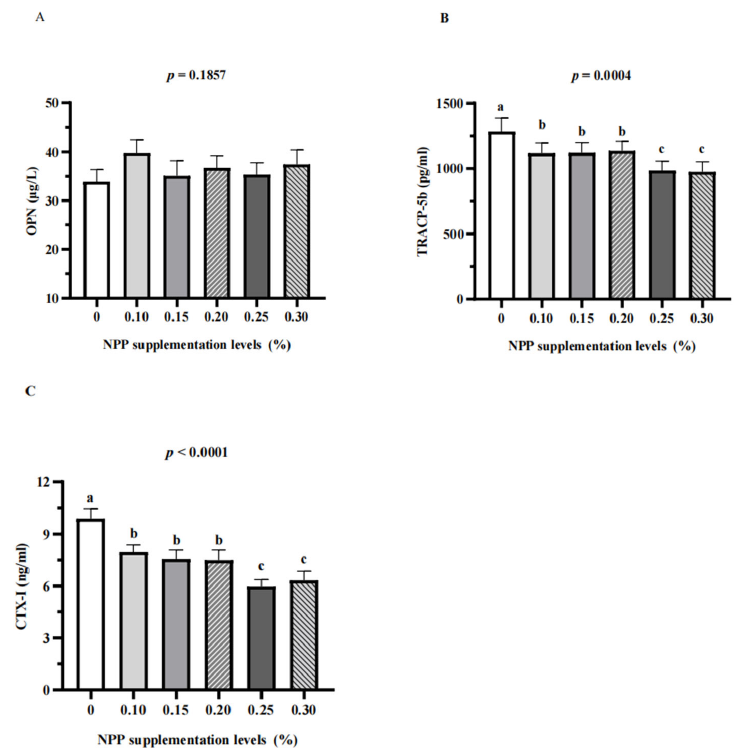
Figure 4. Effect of the level of dietary NPP supplementation on the serum bone resorption markers of Hy-Line Brown laying hens (69–78 weeks of age) fed a phytase-containing diet. OPN = osteopontin ( A ); TRACP-5b = tartrate-resistant acid phosphatase 5b ( B ); CTX-I = C-telopeptide of type-I collagen